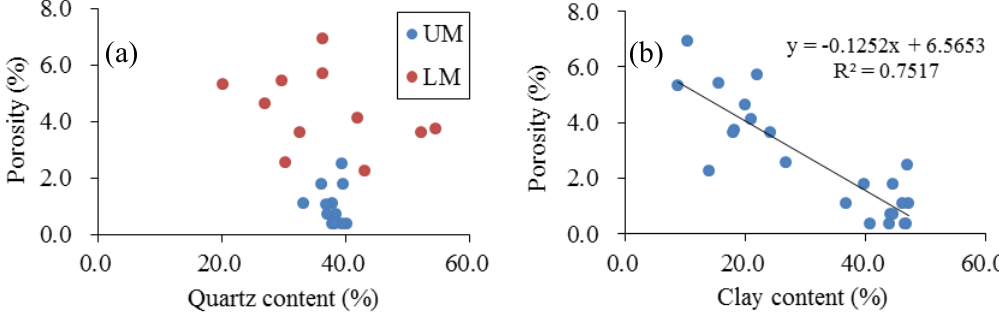
Figure 12. Effects of mineral composition on total porosity: ( a ) quartz; ( b ) clay minerals.